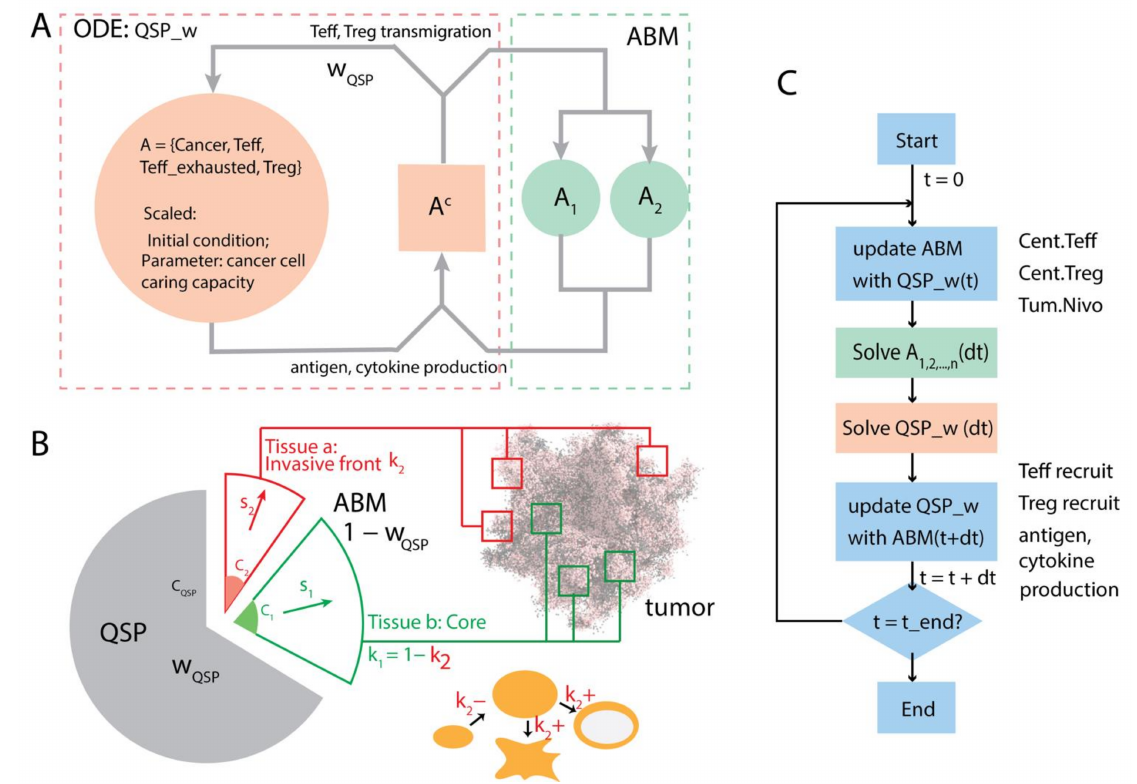
Figure 2. Coupling of QSP and ABM modules during simulation. ( A ) A group of species from the tumor compartment (Set A) including cancer cells, effector T cells (active and exhausted) and regulatory T cells (Tregs) are partially represented with the ABM tumor module. The fraction of tumor tracked in the QSP module is w QSP , and that weight is applied to the initial condition of these species and their transmigration into the tumor compartment. The other 1 − w QSP of the tumor compartment is represented by the ABM module (A1 and A2). The rest of the species (set AC) are fully accounted for by the QSP module, the partially weighted QSP is referred to here as QSP_w . ( B ) Cell counts in the ABM modules are scaled up to account for 1 − w QSP of the tumor when their contribution to the QSP is calculated during the simulation, depending on the number of ROIs chosen and the fraction of each tumor region in the whole-tumor volume. k i could vary in time when the tumor changes in size, shape or undergoes resection during treatment. ( C ) Flow of control during simulations. At the beginning of each time step, some ABM variables are updated from the QSP module, including central compartment concentration of Teff , Treg and anti-PD-1 agent. Then, the ABM module is simulated over time interval dt , followed by the simulation of QSP_w . At the end of the time step, relevant QSP variables in set AC are updated according to ABM simulation